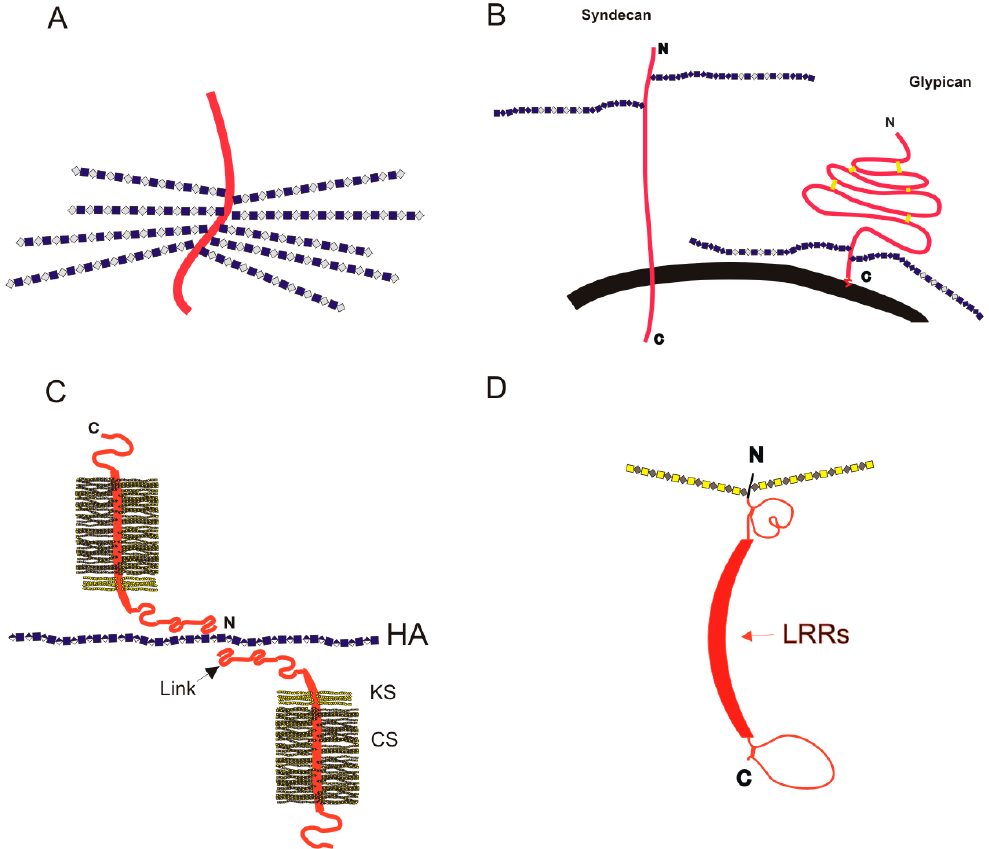
Figure 3. Schematic cartoon images (not to scale) for PGs on the cell surface and in the ECM. Protein chains are shown as red ribbons, and GAG chains are depicted in a simplified form of the symbology recommended by the Consortium for Structural Glycomics [40]; ( A ) the intracellular PG serglycin, bearing closely packed Hp (or oversulfated chondroitin) chains, on a small peptide core; ( B ) cell-surface PGs syndecan and glypican; the cell membrane is shown in black; ( C ) the complex between aggrecan and HA, mediated by Link protein, that forms the structural basis for cartilage elasticity; and ( D ) a generic diagram of a SLRP, such as biglycan or decorin. Between the globular regions near the N- and C-termini the leucine-rich repeats (LRRs) form a curved structure; the dimers can form by interaction between the two offset concave faces of monomers.